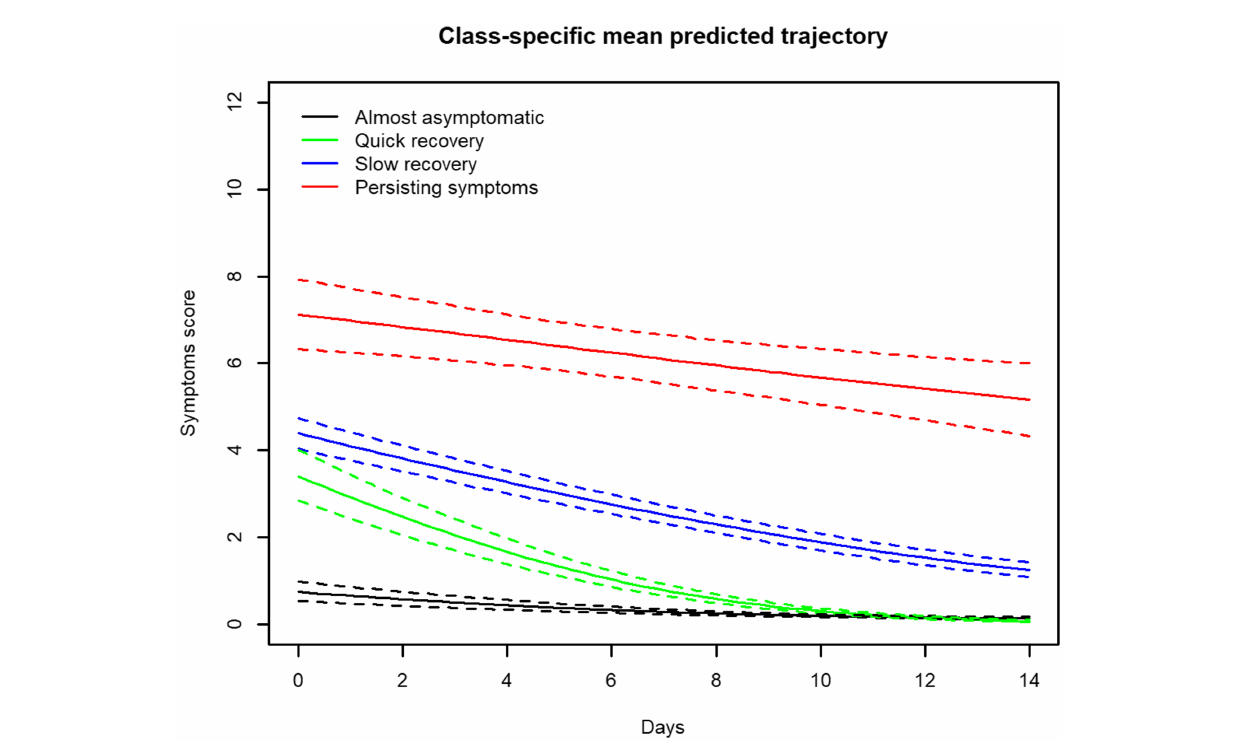
FIGURE 1 Symptom trajectories of 791 adults tested positive for SARS-CoV-2. The symptoms were reported (asked from a list of 16 symptoms) at baseline and every day after the baseline during 14